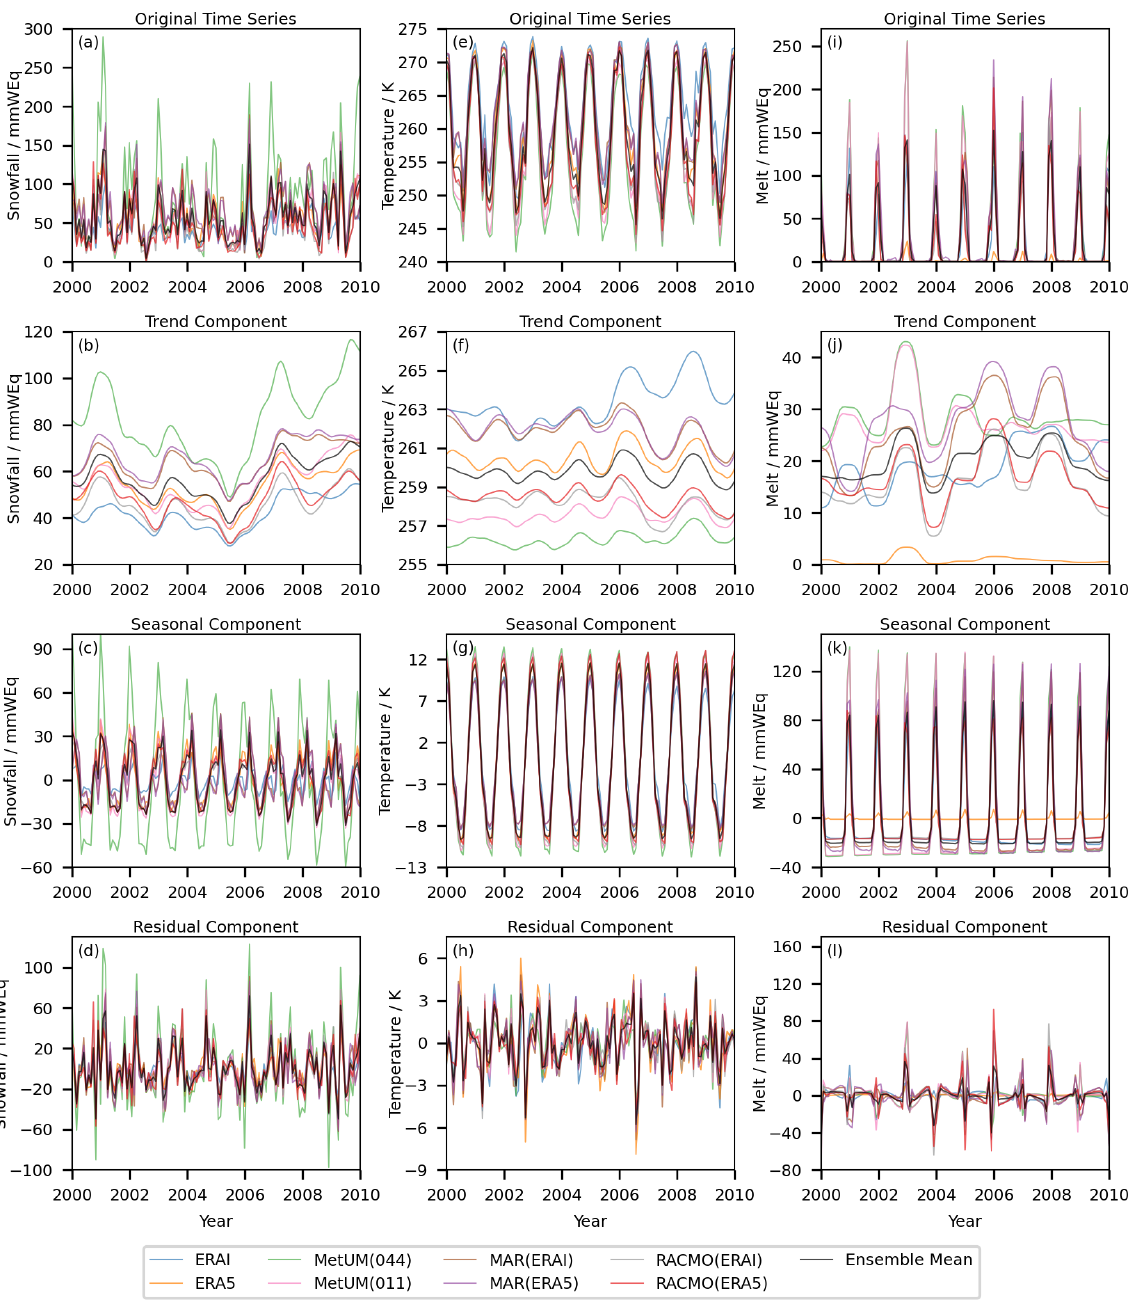
Figure A1. An example of STL decomposition applied to the monthly time series of snowfall (a–d) , surface temperature (e–h) and melt (i–l) for a grid cell near the grounding line on the Larsen C ice shelf. The original time series for the years 2000–2010 are shown (a, e, i) , as are the trend (b, f, j) , seasonal (c, g, k) and residual (d, h, l) decompositions. The model is additive, meaning the sum of trend, seasonal and residual components returns the original time series. Parameter values are n s = 13 and n t =